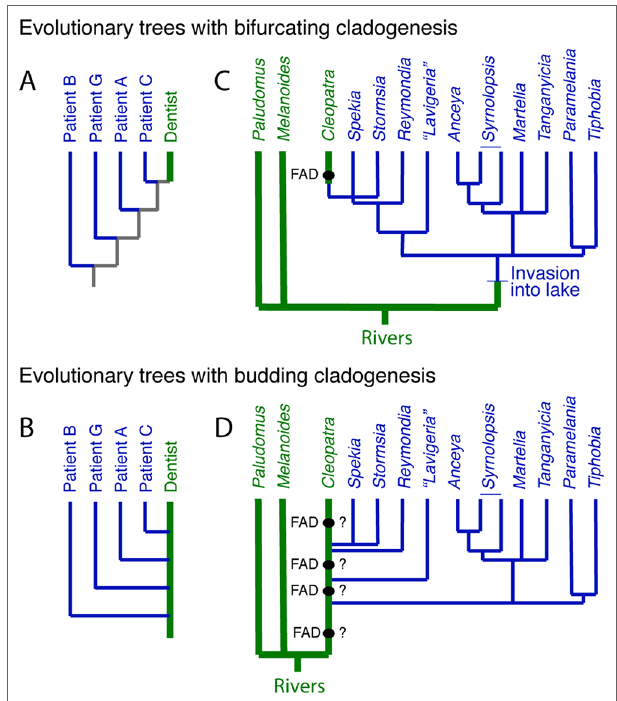
FIGURE 3 | The distinction between bifurcating and budding cladogenesis matters for DNA trees. (A) Part of the evolutionary tree ( y clone of the HIV-1 env V3 region) of the dentist and some of his HIV infected patients from Ou et al. (1992). The gray internal branches indicate that, without additional information, we do not know if the virus in the patients was derived from the dentist or not. (B) The tree from (A) redrawn with budding cladogenesis, making obvious the sequential infection of patients with HIV by the